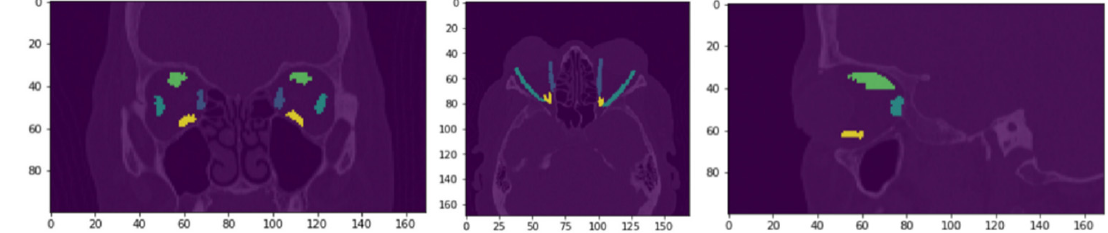
Figure 3. Label-wise annotation of EOMs with EOM masks highlighted on (L-R) coronal, axial, and sagittal CT images. Table 1. Baseline patient characteristics of the training and test groups with mean (and standard deviation) thickness and area in mm and mm 2 respectively.